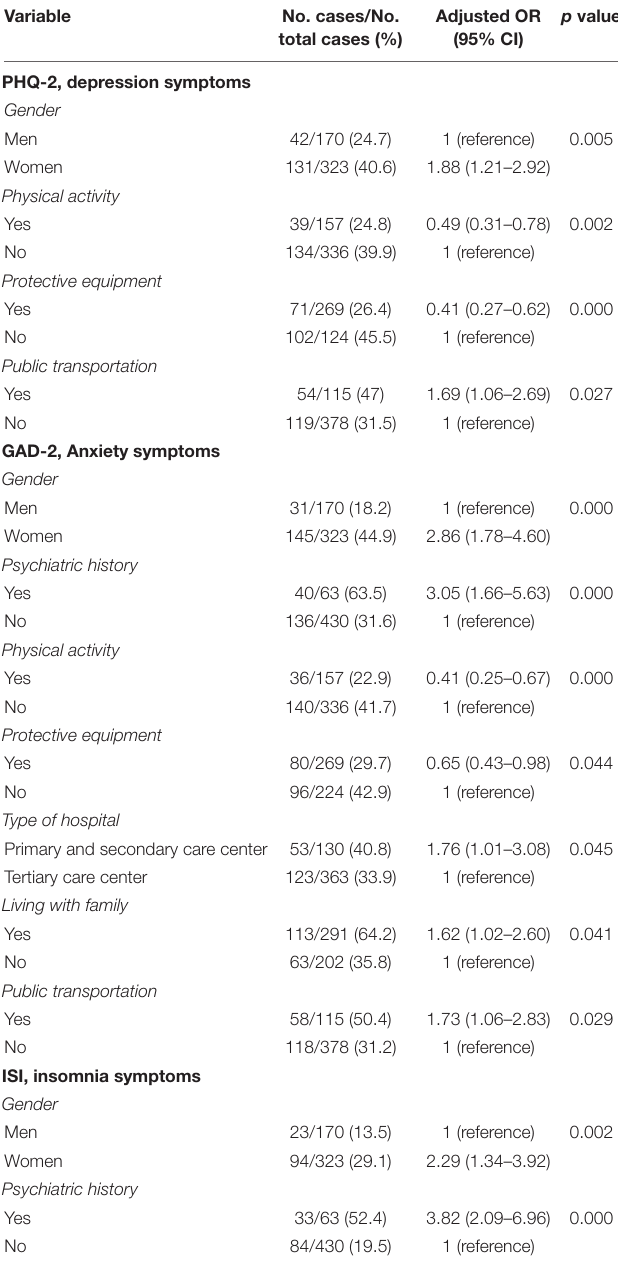
TABLE 3 | Risk and protective factors for mental health outcomes identified by multivariable regression. Variable No. cases/No. total cases